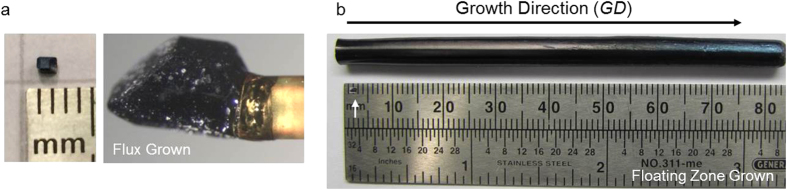
(a) Pictures of a flux grown single crystal (right) and as mounted onto a Kapton covered vanadium post used for neutron diffraction measurements. (b) A single crystal prepared via the floating zone procedure. Also shown is a scaled version of the picture of the flux grown single crystal (white arrow).